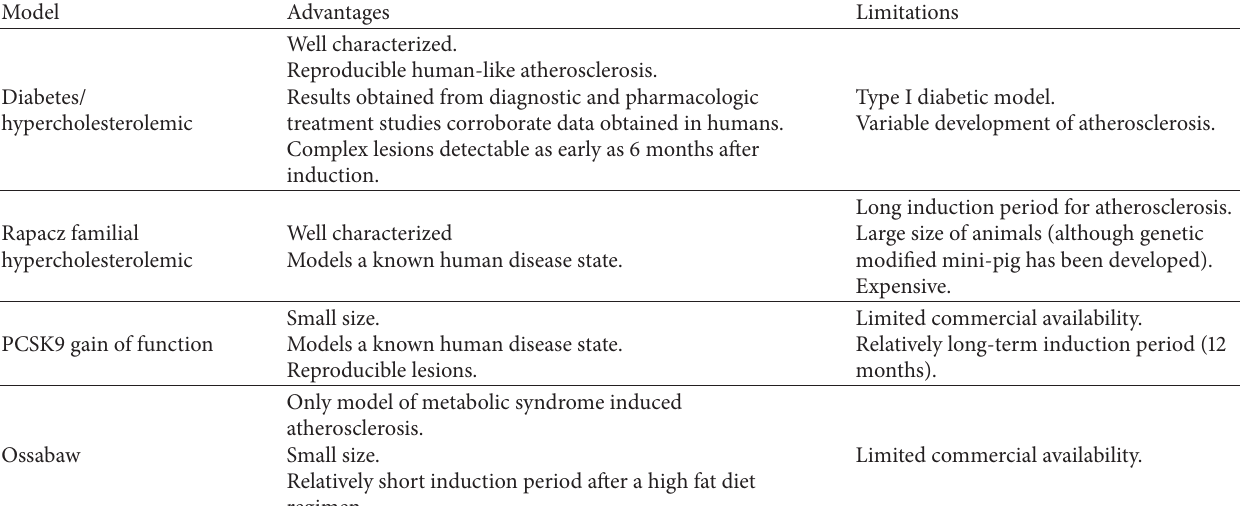
Table 1: Relative advantages and disadvantages of the 4 atherosclerotic porcine models.